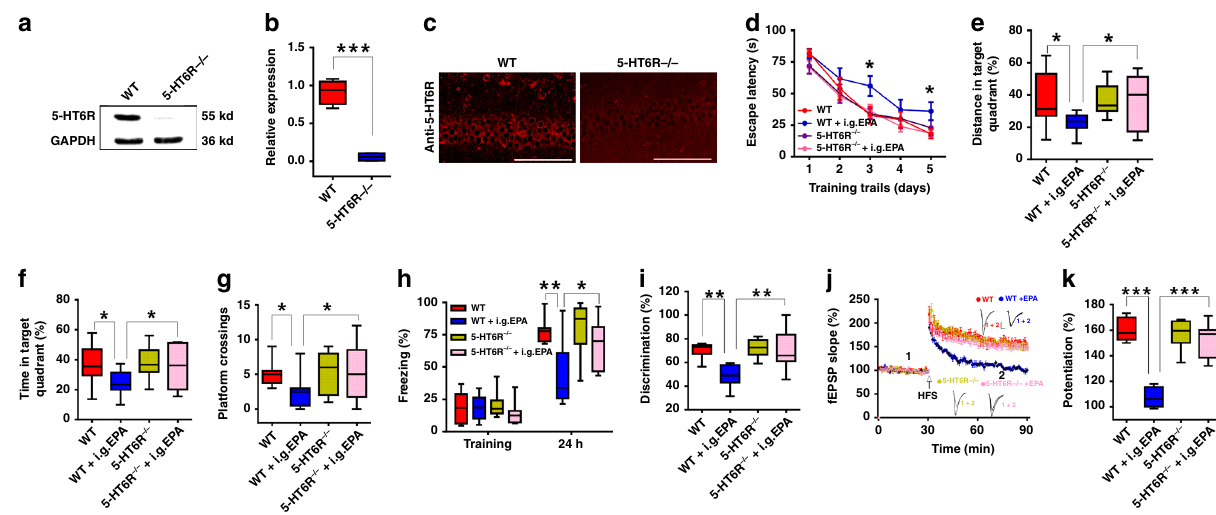
Fig. 5 The impairing effect of EPA disappeared in 5-HT6R KO mice. a , b Western blots of 5-HT 6 R in the hippocampus from 5-HT 6 R KO (5-HT 6 R − / − ) mice and their WT (5-HT 6 R + / + ) littermates ( n = 3 – 4 experiments/group; two-tailed Student ’ s t -test; P < 0.0001). Full-length blots are presented in Supplementary Fig. 9. c Speci fi city characterization of the anti-5-HT 6 R antibodies. Scale bars: 100 μ m. d – k The impairing effect of EPA on learning and memory in the MWM ( d – g : n = 10 – 12 mice/group; d : repeated measures two-way ANOVA, F (3, 200) = 41.279, P = 0.053; e : one-way ANOVA, F (3, 39) = 43.379, P = 0.028; f : one-way ANOVA, F (3, 39) = 41.662, P = 0.02; g : one-way ANOVA, F (3, 39) = 42.726, P = 0.057), contextual fear conditioning ( h : n = 9 – 12 mice/group; one-way ANOVA, F (3, 38) = 46.588, P = 0.001), NOR ( i : n = 9 – 11 mice/group; one-way ANOVA, F (3, 35) = 34.161, P = 0.005), and LTP ( j , k , n = 5 – 8 slices/group; one-way ANOVA, F (3, 24) = 38.908, P < 0.0001) disappeared in 5-HT 6 R KO mice. Data show mean ± s.e.m. Scale bars: 0.5 mV,